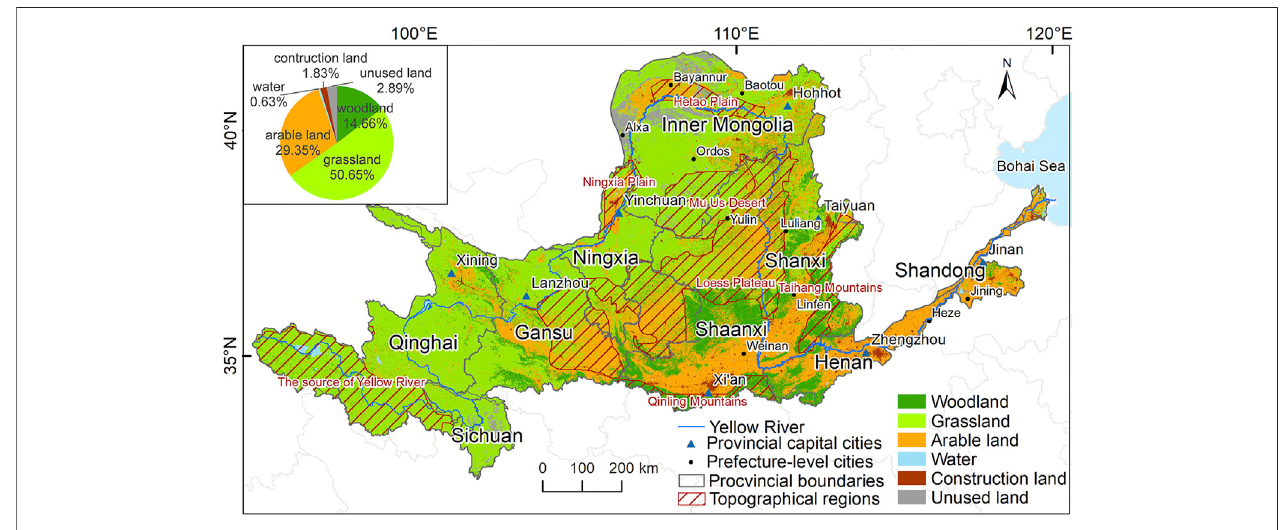
FIGURE 1 | Spatial distribution map of land use in the Yellow River Basin in